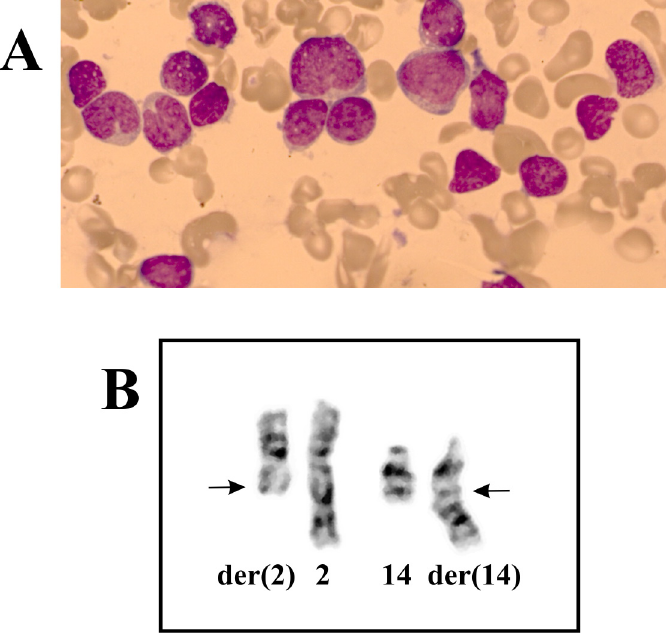
Fig 1. Hematological and cytogenetic data on the AML patient with t(2;14). A) Blasts without granulation and with relatively little cytoplasm in the patient´s bone marrow. B) Partial karyotype showing the der(2)t(2;14) (q22;q32) and der(14)t(2;14)(q22;q32) together with the corresponding normal chromosome homologs; breakpoint positions are indicated by